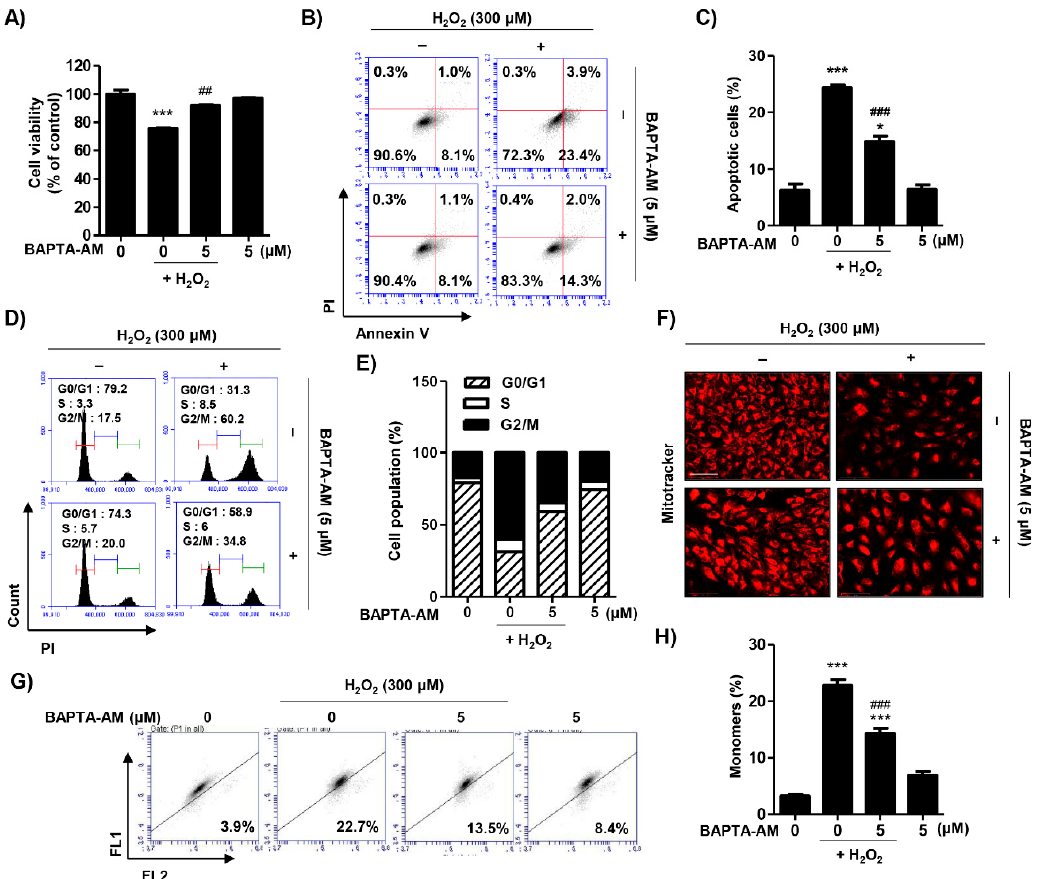
Figure 6. Effect of BAPTA-AM on H 2 O 2 -induced cellular damage in ARPE-19 cells. Cells were pre-treated with or